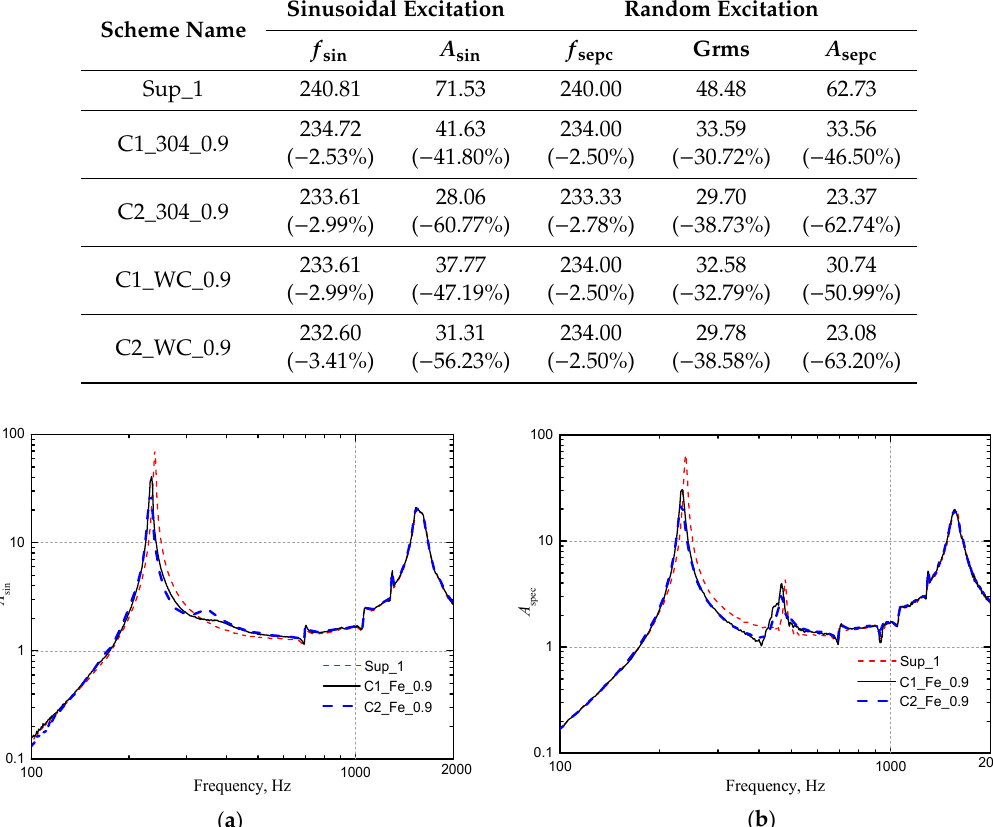
Figure 10. Experiment results of 2 mm stainless steel particle (layering in Y-direction of the cavity): ( a ) Sinusoidal excitation; ( b ) Random excitation.